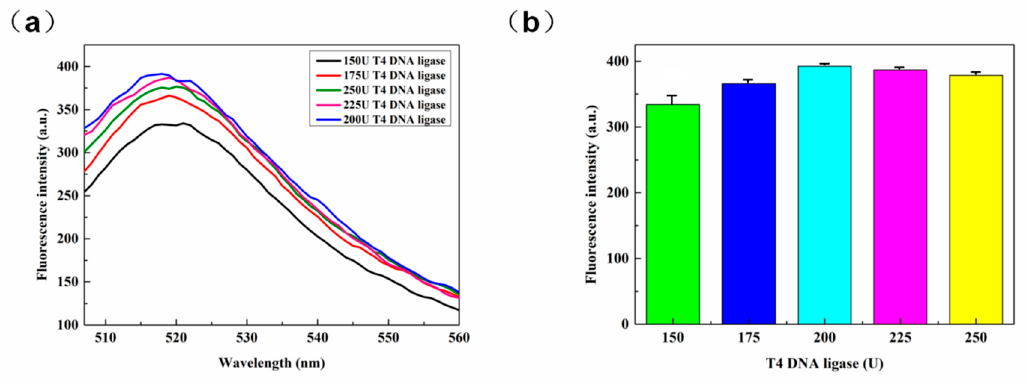
Figure 4. ( a ) Fluorescence spectra for various T4 DNA ligase concentrations; ( b ) comparison of fluorescence intensities for various ligase concentrations.